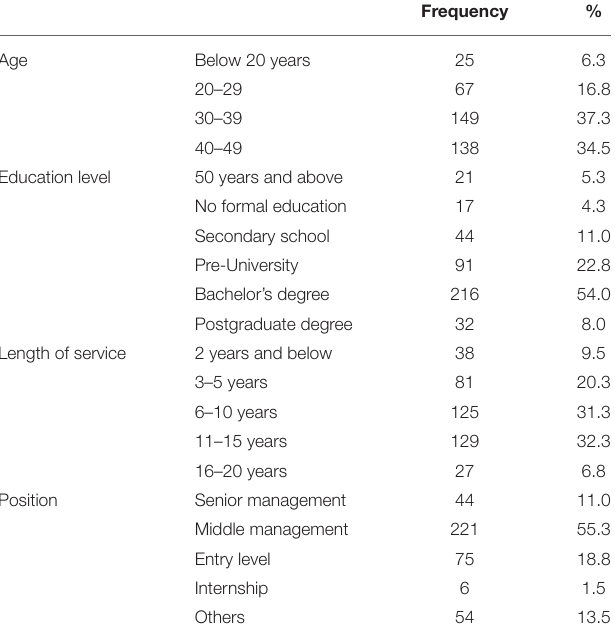
TABLE 1 | Demographic profile of